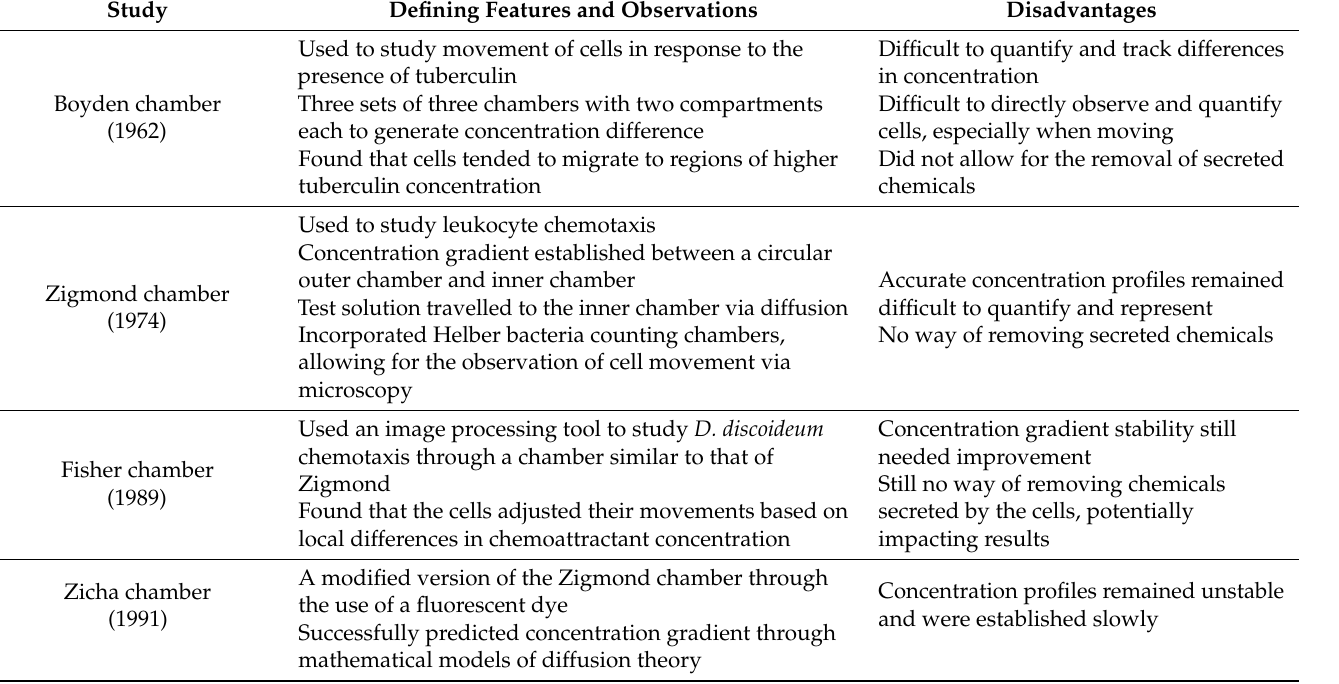
Table 1. Studies on cell chemotaxis using classical diffusion